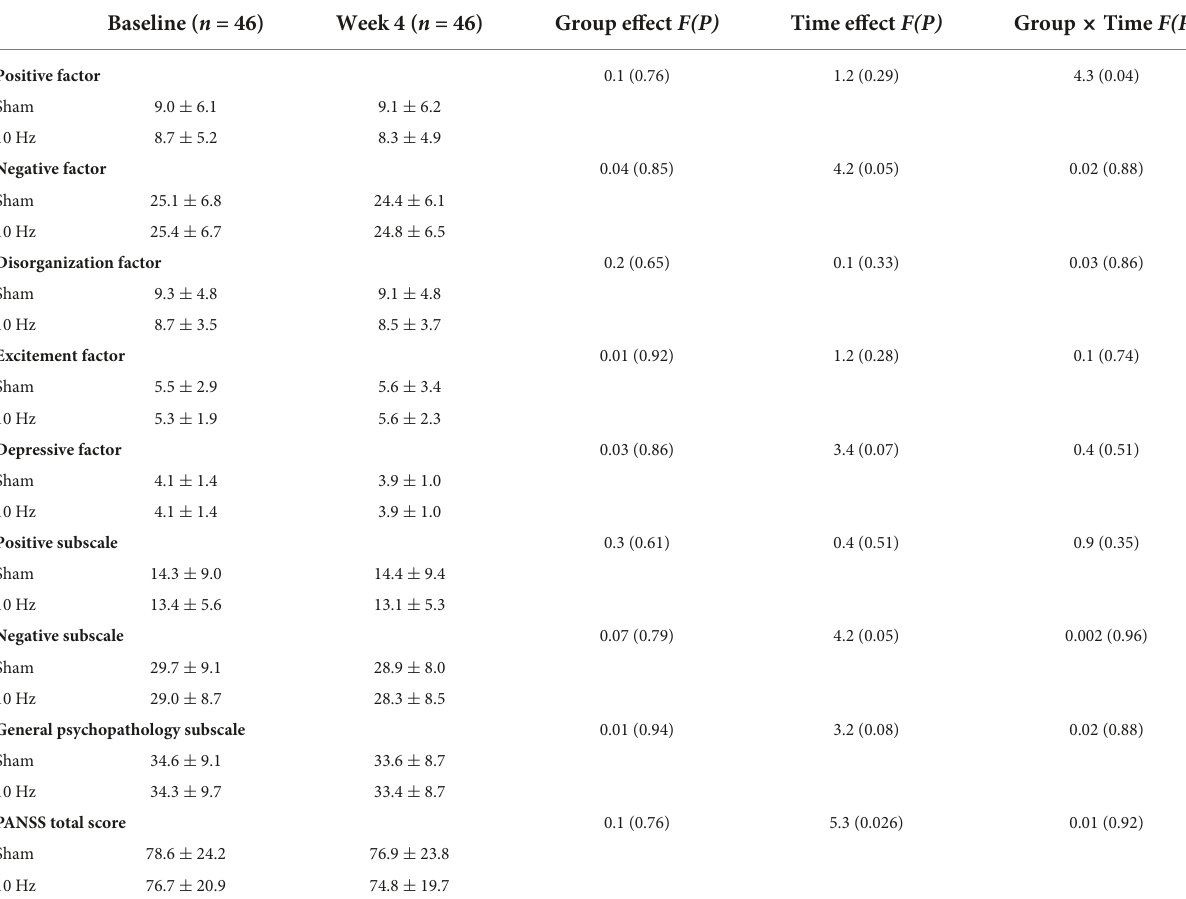
TABLE 2 PANSS five-factor at baseline and at follow-up after treatment in real and sham rTMS